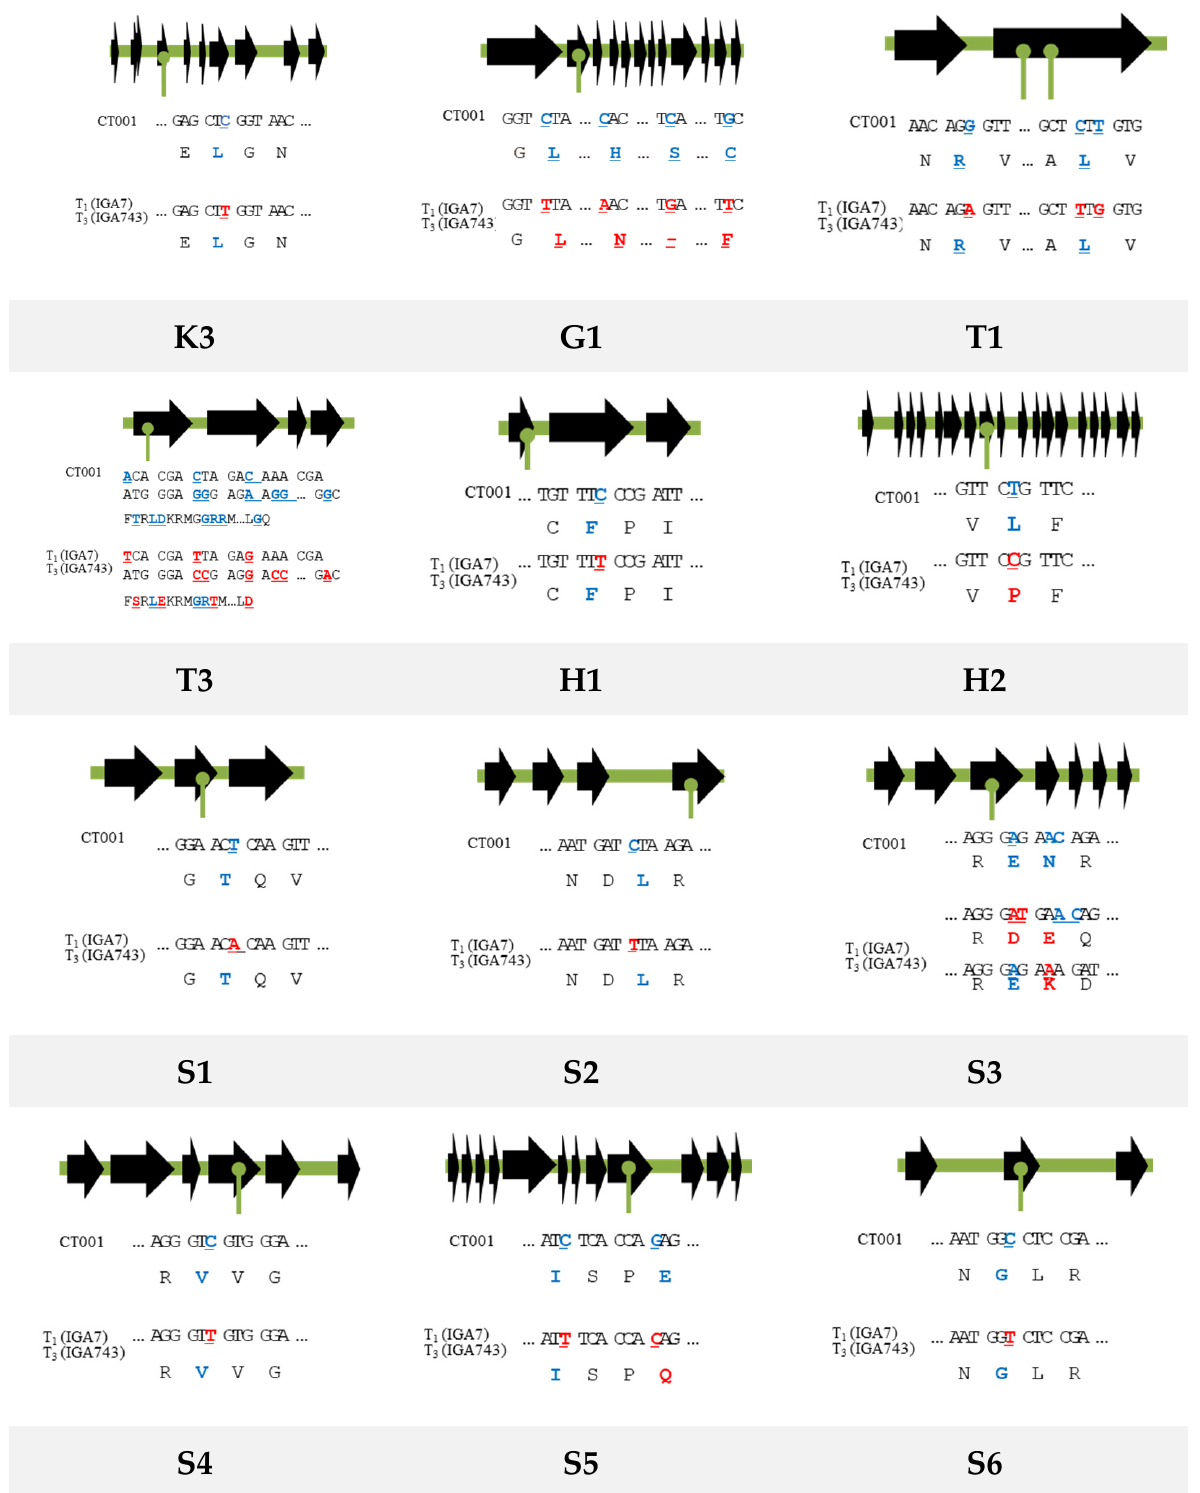
Figure 7. Nucleic acid and amino acid sequence analysis of the RT-PCR products of the target SNPs from non-transgenic and transgenic Chinese cabbage plants. Black arrows indicate exons of each gene and their coding directions. Green lines with a circle indicate the location with genomic variation. Original sequences are in blue and the altered sequences are in red.